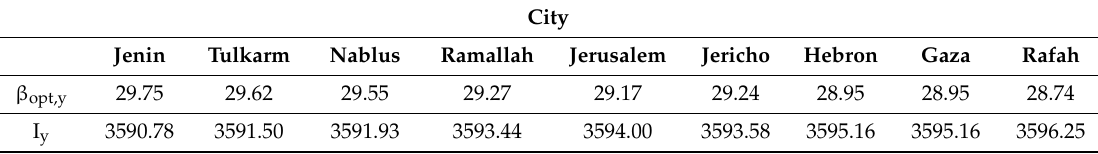
Table 13. The annual optimum tilt angle β opt,y and extraterrestrial radiation I y in kWh / m 2 for the main Palestinian cities.